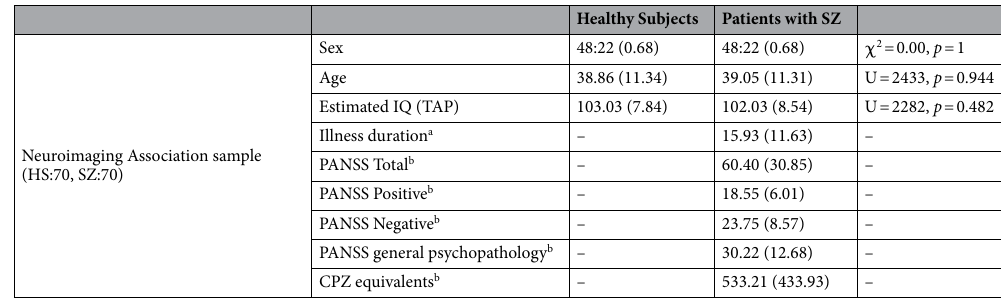
Table 2. Sample description. Information on the healthy subjects (HS) and patients with SZ included in the neuroimaging association study. Sex description includes male:female count (frequency in males). The clinical description of patients includes Illness duration (in years), the PANSS scores, and chlorpromazine (CPZ) equivalent dose (mg/day). All the quantitative variables include the mean value and (standard deviation). a Data of illness duration was available for 67 patients. b Data of PANSS scores and CPZ equivalents were available for 65